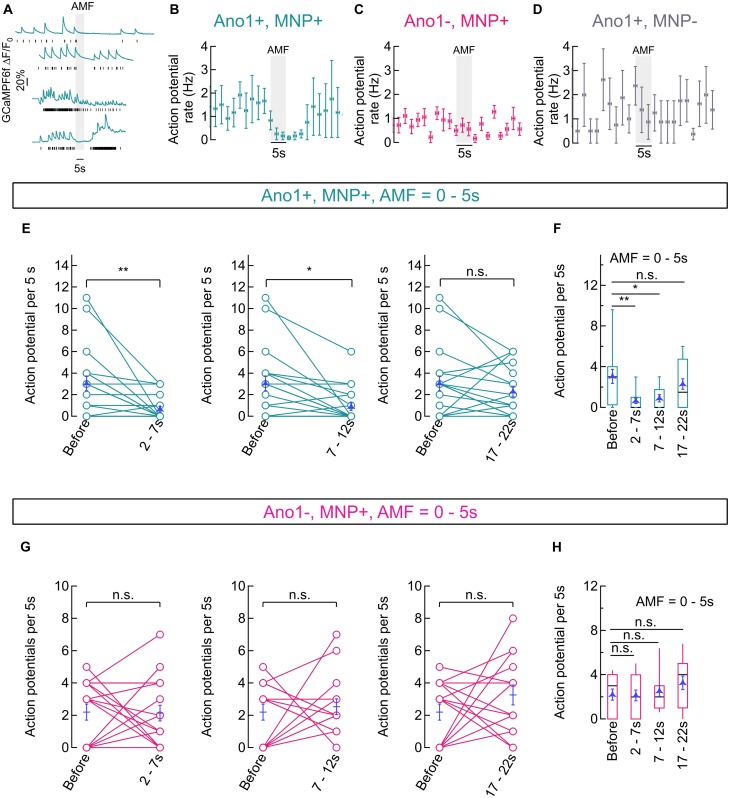
Magneto-thermal silencing of hippocampal neurons. (A) Representative traces of GCaMP6f fluorescence intensity averaged over pixels containing the soma of Ano1/TMEM16A+, MNP+ neurons, exposed to AMF (28.87 ± 1.03 kA/m, 412.5 kHz; gray, solid). Black sticks under each plot indicate respective calculated action potential (AP) events. (B) Binned (mean ± SEM, n = 9) AP firing rates (binned over 2 s, Hz) of Ano1/TMEM16A+, MNP+ neurons. Starting temperature was 37°C and AMF (28.87 ± 1.03 kA/m, 412.5 kHz; gray, solid) was applied for 5 s. (C,D) Binned (mean ± SEM, n = 9) AP firing rates (2 s bins, Hz) of Ano1/TMEM16A-, MNP+ (n = 15, C) and Ano1/TMEM16A+, MNP- (n = 5, D) neurons are shown. Starting temperature was 37°C and AMF (28.87 ± 1.03 kA/m, 412.5 kHz; gray, solid) was applied for 5 s in both cases. (E,F) Shows the comparison between AP firing rates recorded in 5 s time intervals corresponding to various temperature ranges achieved during magnetothermal membrane heating (and subsequent cooling) in Ano1/TMEM16A+, MNP+ neurons (see Figure 5B). Connected plots in E compares AP firing rates at different time bins after AMF application (starting at 0 s) with AP rates before AMF, in Ano1/TMEM16A+, MNP+ neurons. Overlaid blue markers show mean ± SEM (n = 20). AP rates before AMF application (37°C) was 3.05 ± 0.68 AP per 5 s; AP rates during 2–7 s (38–40°C) was 0.65 ± 0.25 AP per 5 s; AP rates during 7–12 s (38–39°C) was 0.90 ± 0.35 AP per 5 s; and AP rates during 17–22 s (37–38°C) was 2.30 ± 0.51 AP per 5 s. Significance level of each comparison is indicated alongside. The firing rate suppression was significant in 2–7 s and 7–12 s intervals (p = 0.0032 and 0.0094, respectively), while insignificant rate change was observed in the 17–22 s bin (p = 0.3858), unpaired T-test. Box and whisker plot in (F) summarizes the results in (E). Boxes span from 2nd to 3rd quartile (box top, 75% and box bottom, 25%), while whiskers indicate 10th and 90th percentiles. The black lines dividing the boxes indicate the median, while mean ± SEM values are overlaid in blue. (G,H) Shows the comparison between AP firing rates recorded in 5 s time intervals corresponding to various temperature ranges achieved during Magnetothermal membrane heating (and subsequent cooling) in Ano1/TMEM16A-, MNP+ neurons. Connected plots in (G) compares AP firing rates at different time bins after AMF application (starting at 0 s) with AP rates before AMF, in Ano1/TMEM16A-, MNP+ neurons. Overlaid blue markers show mean ± SEM (n = 15). AP rates before AMF application (37°C) was 2.20 ± 0.50 AP per 5 s; AP rates during 2–7 s (38–40°C) was 2.13 ± 0.48 AP per 5 s; AP rates during 7–12 s (38–39°C) was 2.53 ± 0.49 AP per 5 s; and AP rates during 17–22 s (37–38°C) was 3.53 ± 0.61 AP per 5 s. Significance level of each comparison is indicated alongside. The firing rate change was significant in all cases: 2–7 s, p = 0.9245; 7–12 s, p = 0.6364; and 17–22 s, p = 0.1044, unpaired T-test. Box and whisker plot in (H) summarizes the results in (G). Boxes span from 2nd to 3rd quartile (box top, 75% and box bottom, 25%), while whiskers indicate 10th and 90th percentiles. The black lines dividing the boxes indicate the median, while mean ± SEM values are overlaid in blue. ∗p < 0.05, ∗∗p < 0.005.